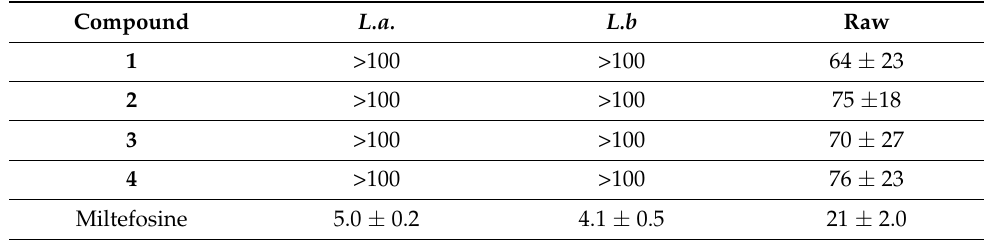
Table 3. Leishmanicidal activity against leishmanial promastigotes ( L.a : Leishmania amazonensis ; L.b. : L. braziliensis ) and cytotoxicity in Raw murine macrophage cell cultures (Raw), of compounds 1 – 4 and the positive control miltefosine. The data are given as IC 50 values in µ g/mL (see Experimental section for